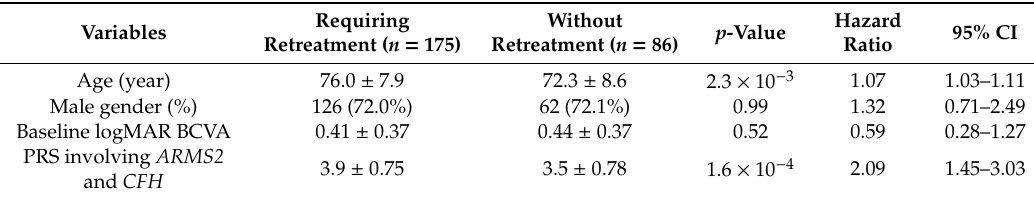
Table 4. Comparison of baseline characteristics between patients requiring retreatment and patients without requiring retreatment.